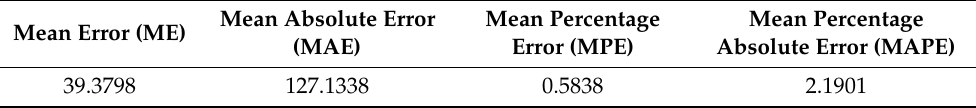
Mean error indicates a slight positive deviation from zero. This means that the ob- tained forecasts are slightly underestimated. Mean absolute error indicates that the actual